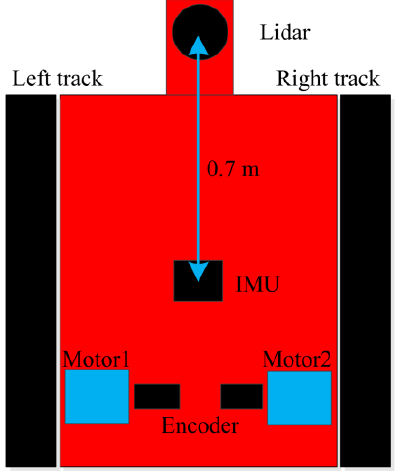
Figure 7. Schematic diagram of the sensor installation positions. Table 1. Main parameters of the RPLIDAR A2 Lidar.